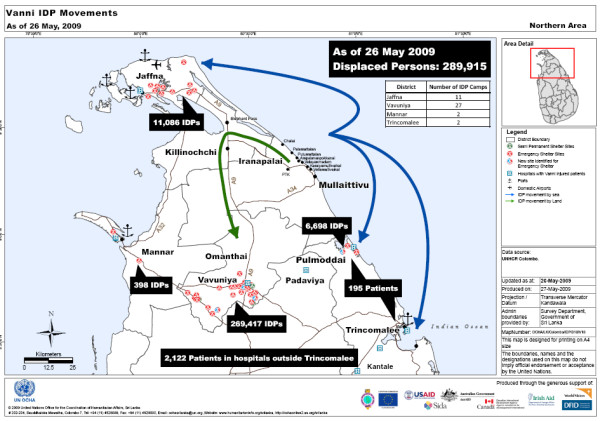
Map of Vanni IDP's [72]. Movement of the Vanni IDP's